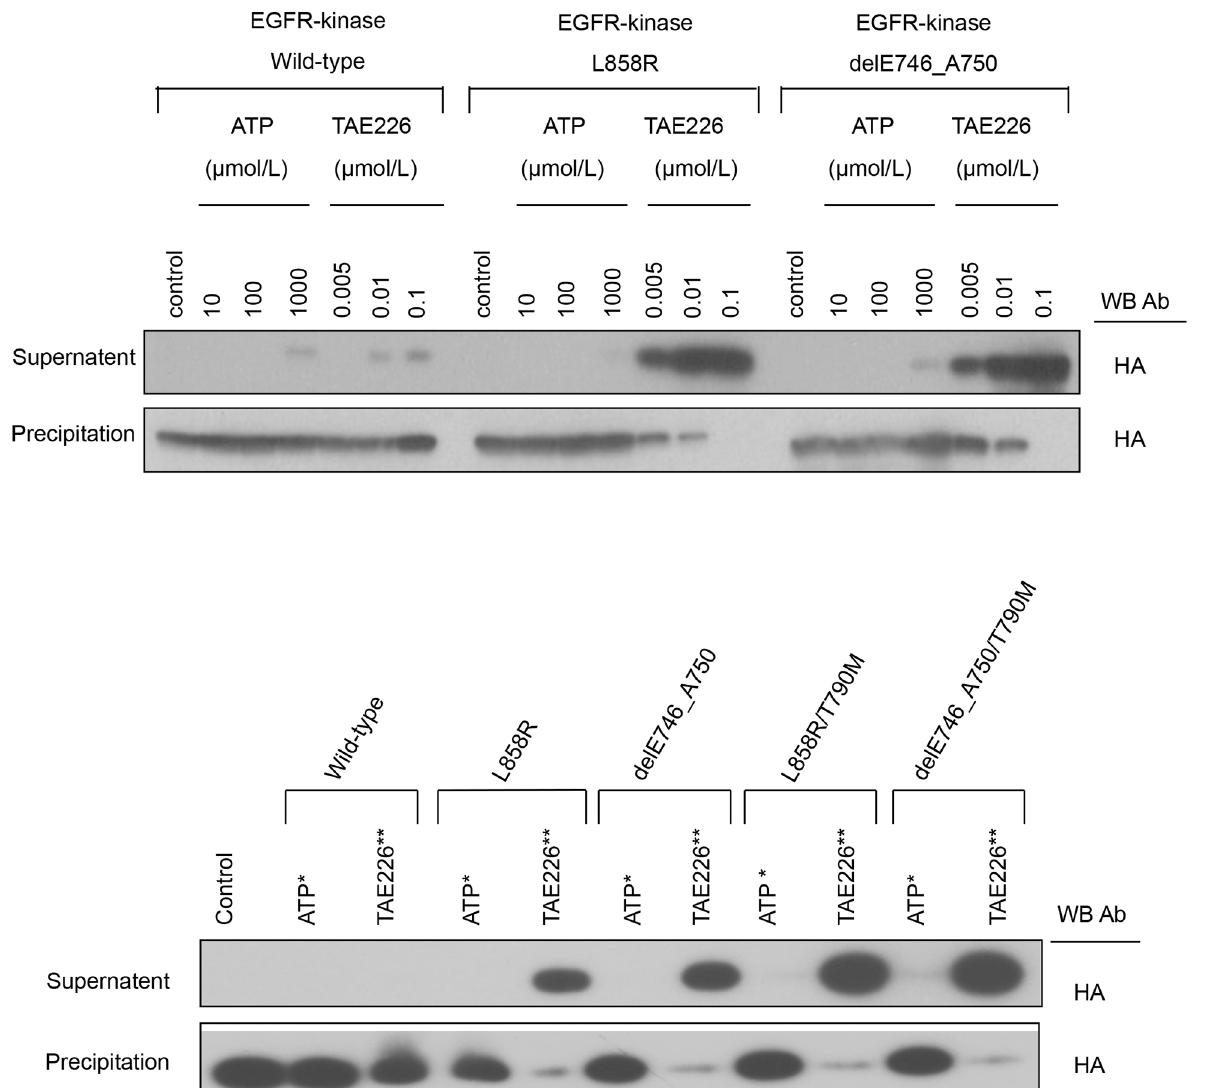
Fig 2. The binding affinity of TAE226 to EGFR kinases. A) common EGFR mutant kinases and B) T790M containing EGFR mutant kinases. The five types of EGFR kinases, wild-type, exon 21 L858R mutation (L858R) or exon 19 deletion (delE746_A750), T790M in tandem with the L858R mutation (L858R/ T790M), and T790M in tandem with delE746_A750 (delE746_A750/T790M), which competitively bind to ATP or TAE226, were extracted and were incubated with beads-modified ATP. TAE226 or the recombinant ATP was added to compete with beads-modified ATP for the binding to EGFR kinases. The EGFR kinase binging with the beads-modified ATP was present in precipitation, and the EGFR kinase binding with TAE226 (or recombinant ATP) was present in supernatant. Western blotting was performed to detect EGFR kinases in each component using a HA antibody. * , at the concentration of 10 μ M for ATP; ** , at the concentration of 0.005 μ M for